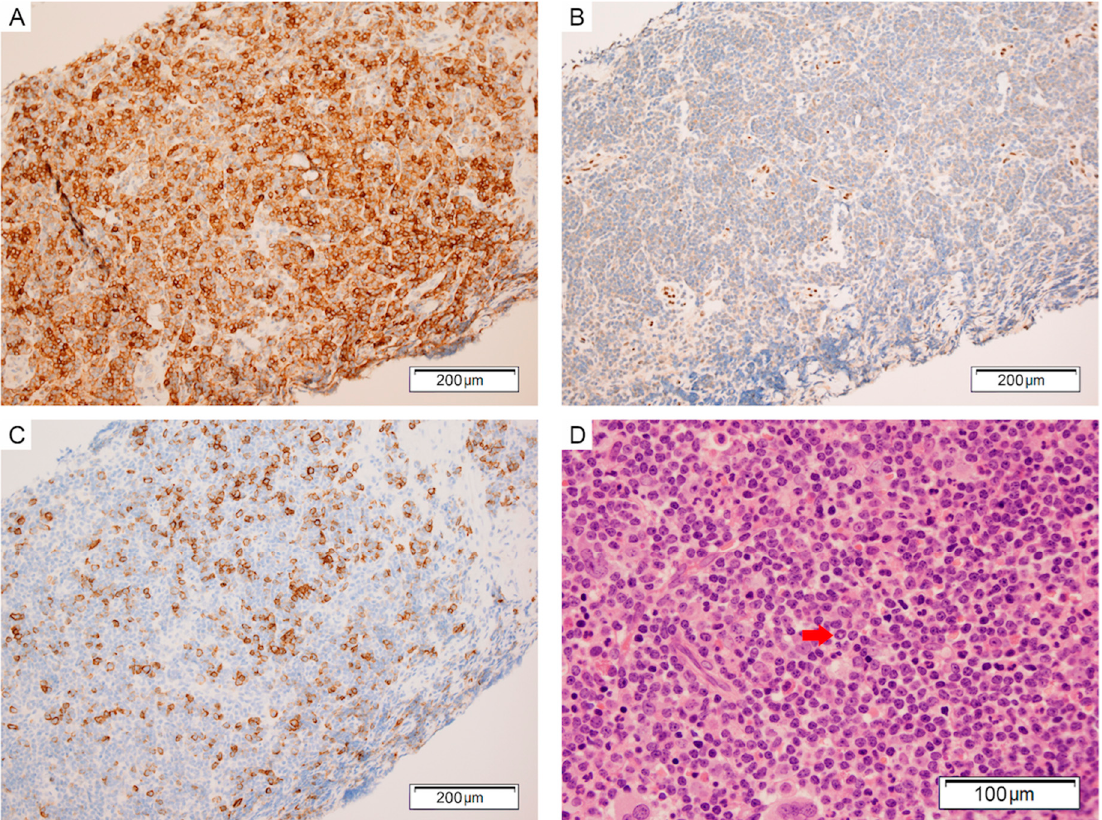
Figure 1. ( A – C ) Inguinal lymph node core biopsy; ( A ) CD10 is positive in the lymphoma cells; ( B ) LMO2 is negative in the lymphoma cells; ( C ) CD138 is positive in mature plasma cells; ( D ) Bone marrow trephine containing a diffuse infiltrate of small mature lymphocytes with interspersed plasma cells. Note the Dutcher body (arrow).